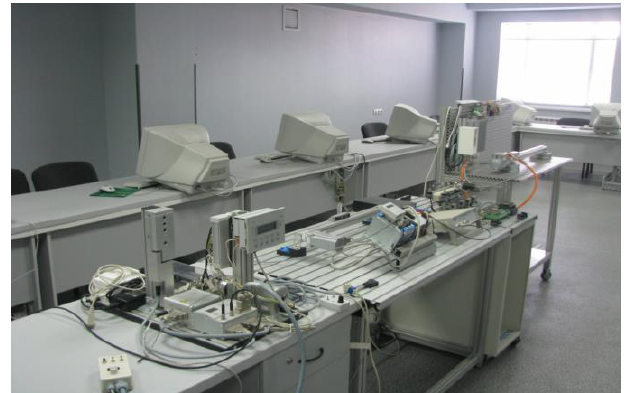
Figure 10. Laboratory of automated electric drive